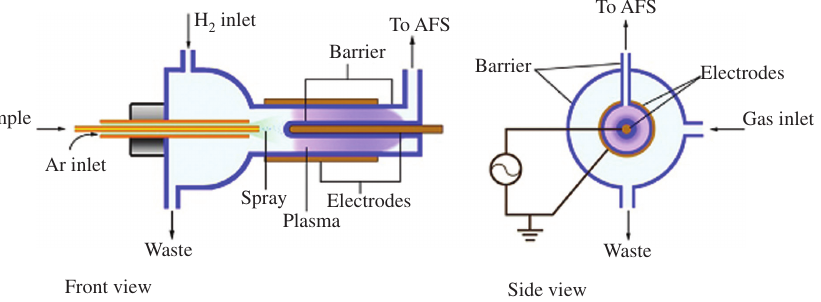
Figure 6 Schematic diagram of the hydrogen DBD plasma-CVG-AFS experiment setup. Reproduced from Yang et al. (2014) with permission of Elsevier.